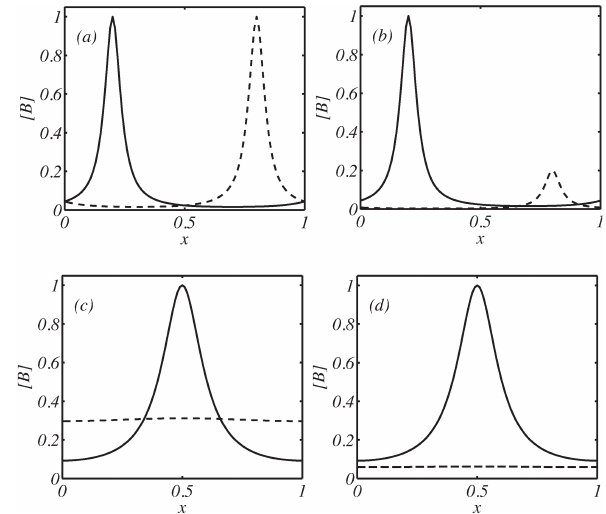
Fig. 5. Example profiles of [ B ] from the model problem for small (solid line) and large (dashed line) times illustrating the evolution of [ B ] under different conditions: (a) Pe (cid:29) 1 and NE (cid:28) 1, (b) Pe (cid:29) 1 and NE (cid:29) 1, (c) Pe (cid:28) 1 and NE (cid:28) 1, (d) Pe (cid:28) 1 and NE (cid:29) 1.